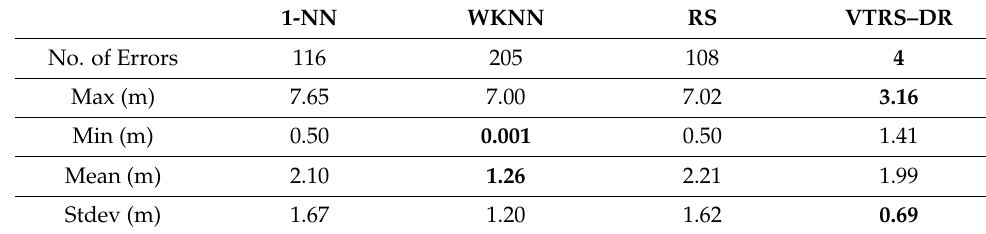
Figure 5. The positioning error distance of four methods via 205 RPs in Case 2. Table 7. Statistical comparison of four methods in Case 2 at error positions.